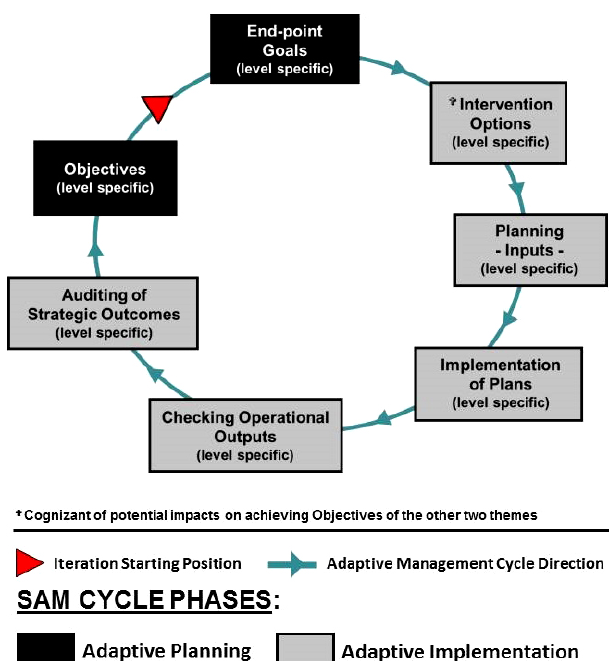
Fig. 4 . The generic horizontal structure of the strategic adaptive management (SAM) cycle used within the SAM Reflexive Learning Framework (SRLF) entities. Two components of the SAM Adaptive Planning Phase and five components of the Adaptive Implementation Phase are given. Determining the Objectives and associated End-point Goals commences the SAM cycle process, in the clock-wise direction. Importantly, in determining “Intervention Options” for one particular theme, there must be cognizance of potential impacts on achieving objectives linked to the other two themes. This generic SAM cycle horizontal structure is used at SRLF Level-1, Level-2, and Level-3 as detailed in Table